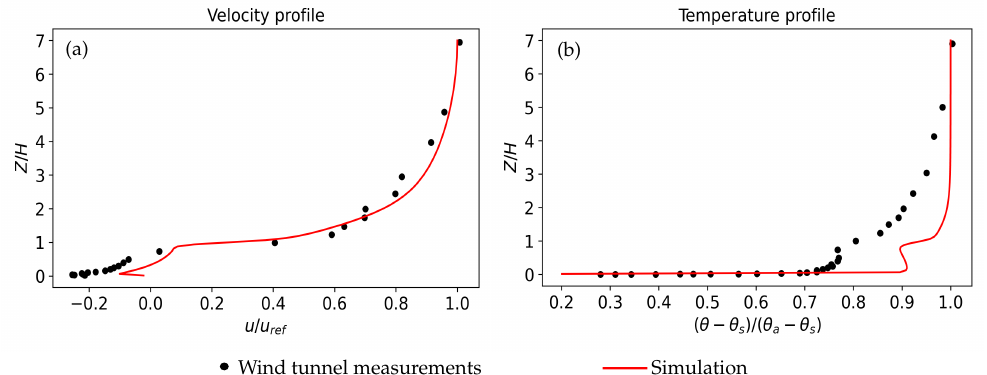
Figure 2. Validation simulation: wind-tunnel measurement vs. simulation results for velocity ( a ) and temperature ( b